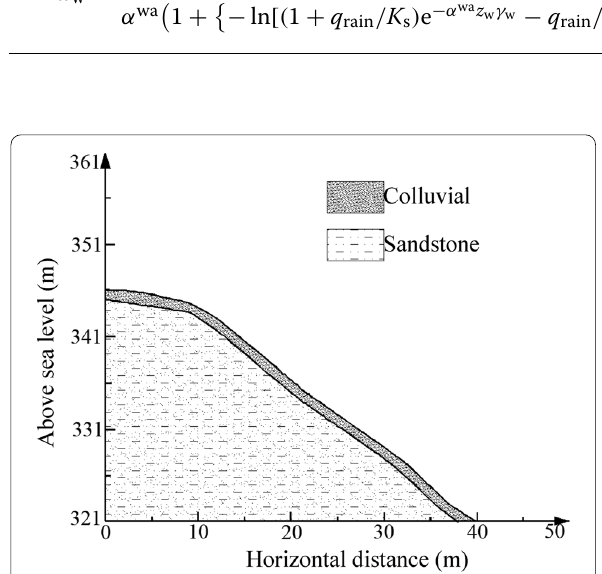
Fig. 4 Schematic diagram of the field monitoring hillslope in Alameda County, California (Chen et al. 2017)